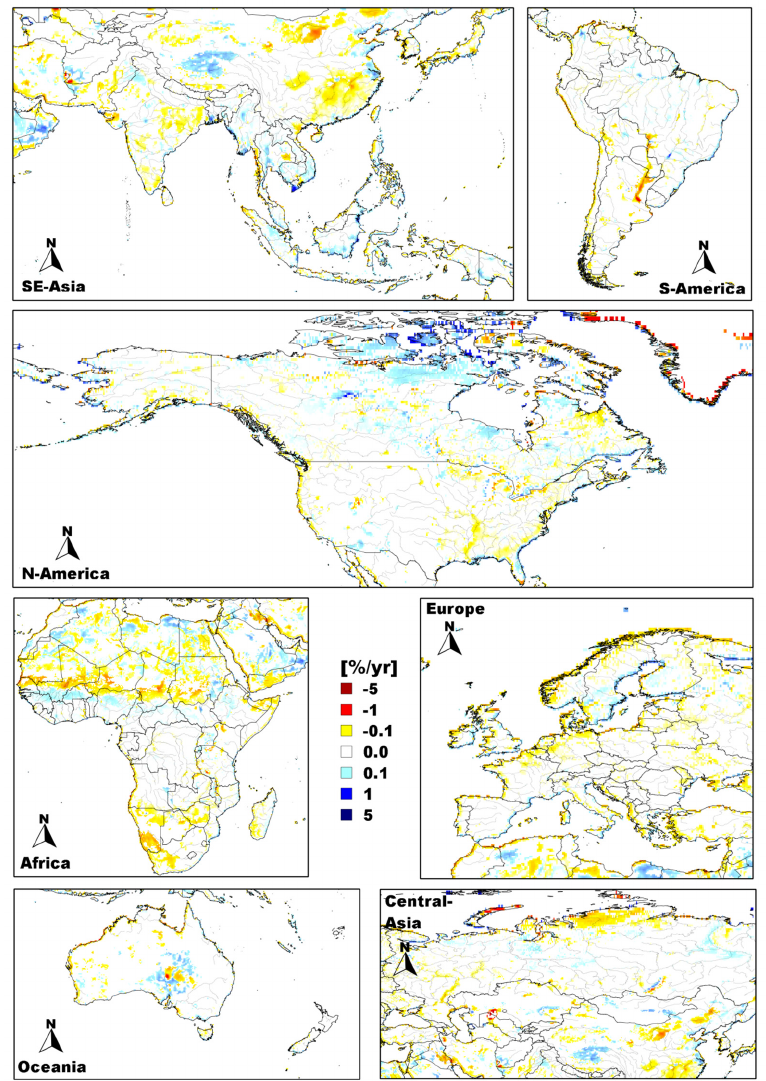
Figure 15. Trend maps of the annual FW means over Southeast Asia (10 ˝ S–45 ˝ N, 135 ˝ E–55 ˝ E), South America (57 ˝ S–19.5 ˝ N, 33.5 ˝ W–83 ˝ W), North America (25 ˝ N–80 ˝ N, 50 ˝ W–170 ˝ W), Europe (30 ˝ N–75 ˝ N, 40 ˝ E–15 ˝ W) and Central Asia (25 ˝ N–80 ˝ N, 120 ˝ E–35 ˝ E) as determined from combined, v1-ERS (1992–1999) and v1-QSCAT (2000–2008) monthly means. The annual FW trend was approximated from the slope of the least-square best fit-line and trend significance was assessed at a minimum 95% ( p < 0.05) probability level. Only statically significant trends are shown. Actual figure color is a linear interpolation of the colors in the legend. Map projection same as Figure 2. Distance covered by one degree of latitude is approximately 111-km.